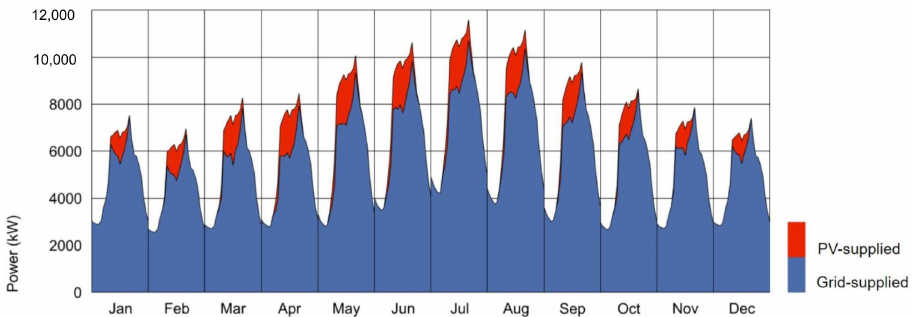
Figure 17. Average daily electricity consumption/source